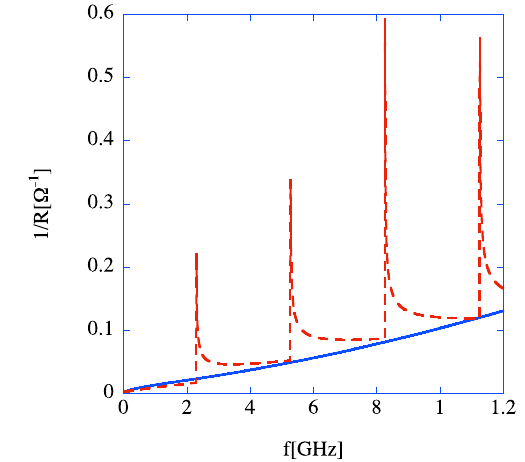
FIG. 3. (Color) Comparison of the admittance, calculated by Eq. (11) (red curve) and Eqs. (15) and (16) (blue curve),